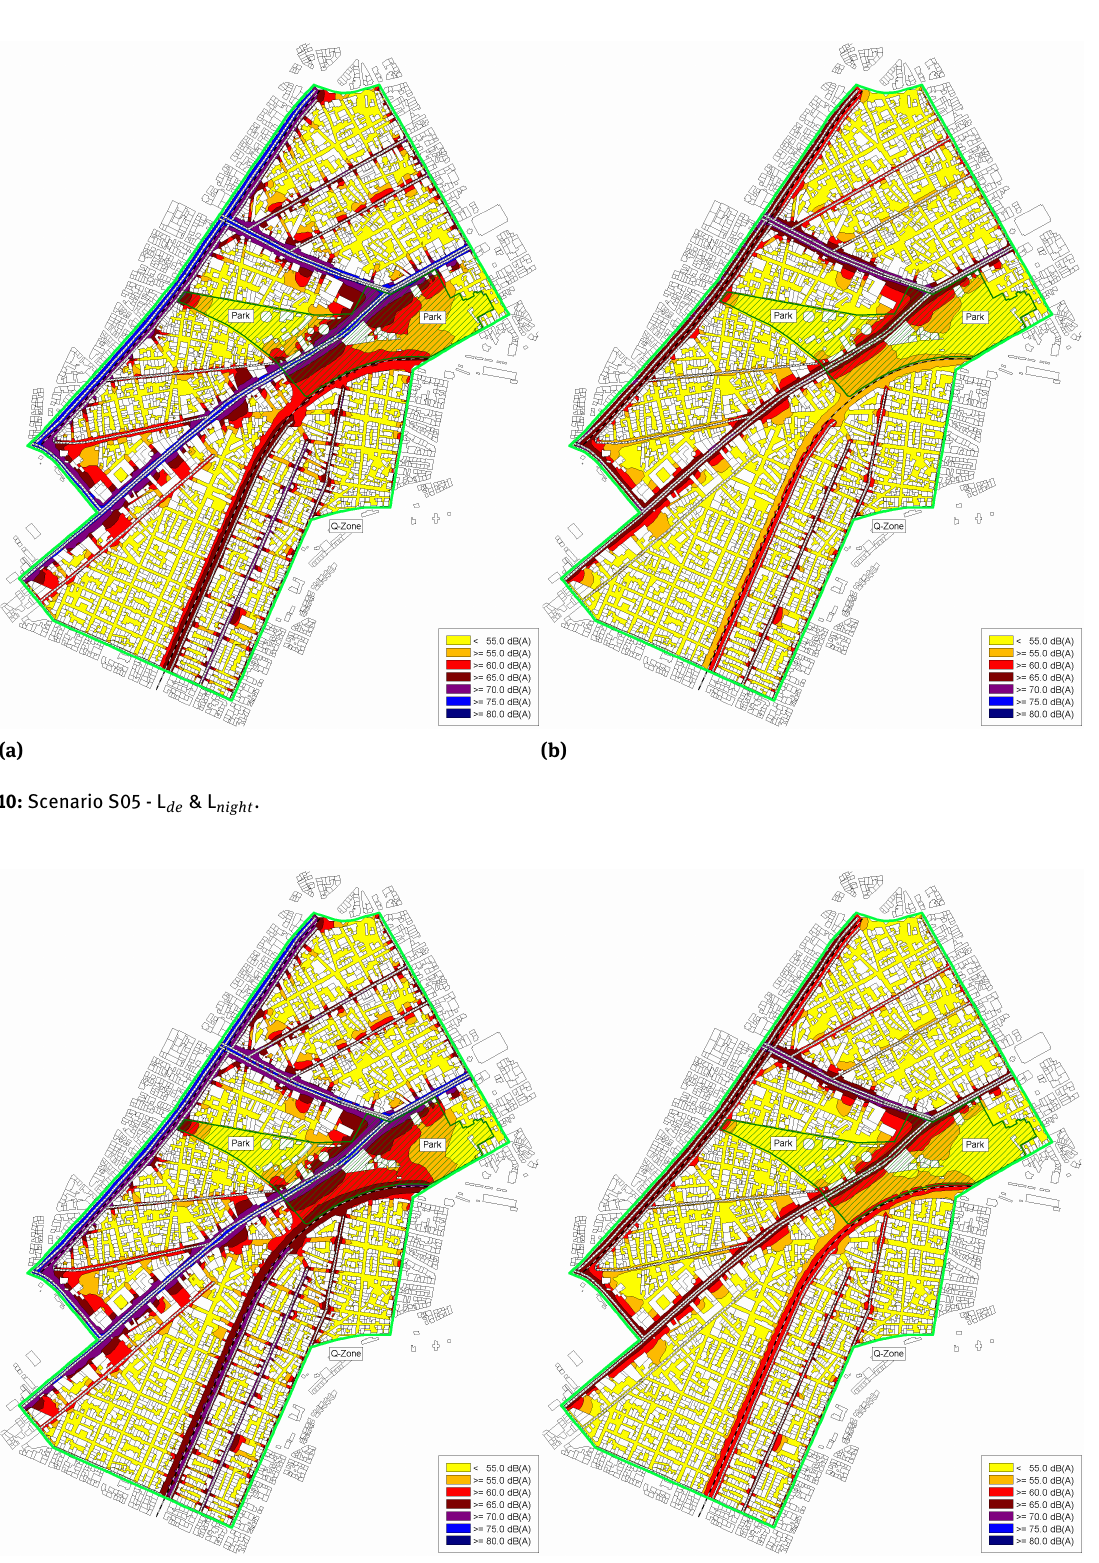
Figure 11: Scenario S06 - L